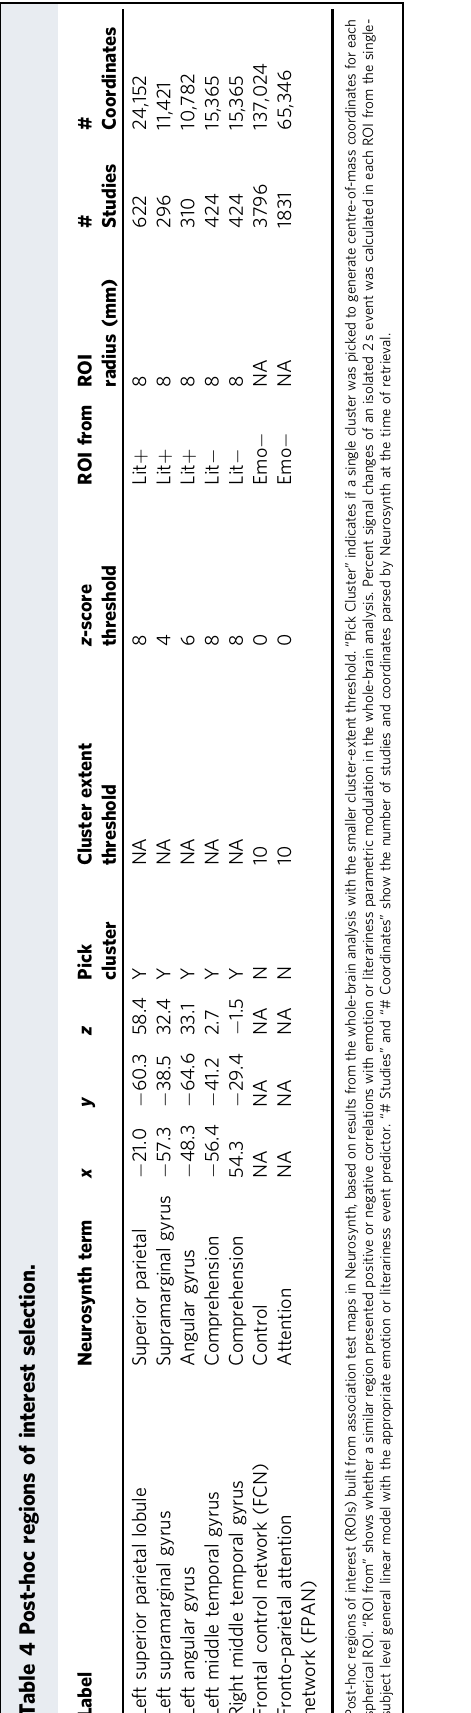
Fig. 5a), and the frontal control network and the frontoparietal attention network for the emotional intensity analysis (see Fig. 5b). We used anatomical and functional terms to generate meta-analysis maps using Neurosynth ’ s “ association tests ” 106 (see Table 4 for details) that approximated the regions we found to be sensitive to literariness and emotional intensity in the WBA. The association test reveals brain regions that are more consistently activated in studies with the target term than in studies without (see https://neurosynth.org/faq/). All meta-analysis maps were corrected for multiple comparisons at false discovery rate (FDR) q <0.01. We then thresholded the maps using z -scores to isolate one reasonably sized cluster around each anatomical region. A custom Matlab script